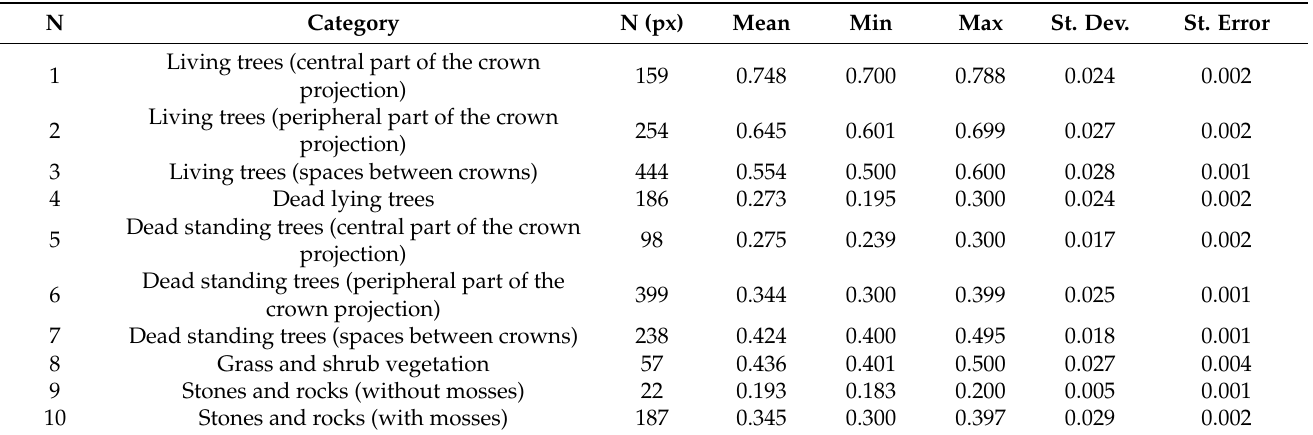
Table 3. NDVI of different categories in the bark beetle spots.